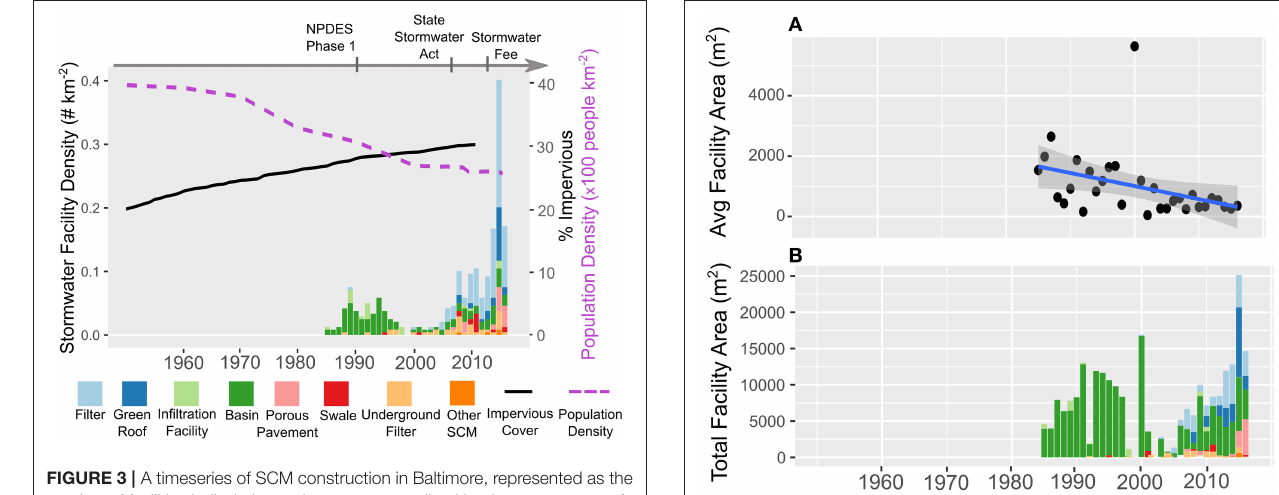
FIGURE 3 | A timeseries of SCM construction in Baltimore, represented as the number of facilities built during a given year, normalized by the current area of the city. The arrow at the top denotes important events influencing stormwater management, the black line graph represents impervious surface change in Baltimore over several decades, and the dotted purple line graph indicates change in population density.